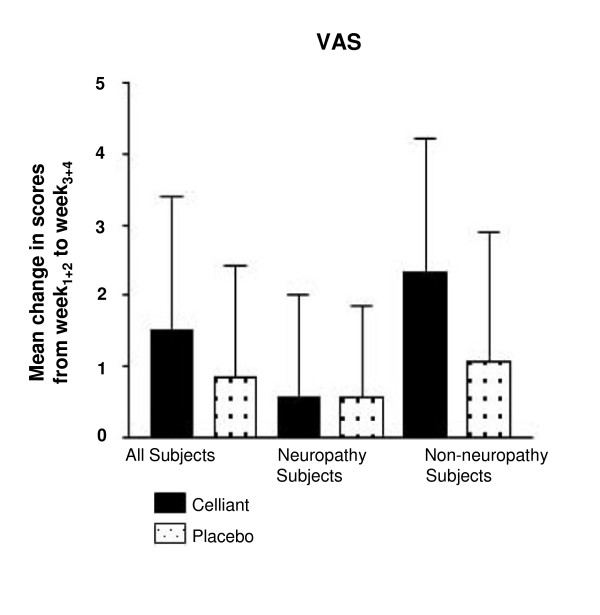
Results of the VAS. The difference between mean W1+2 and mean W3+4 scores is depicted. Solid bars report Celliant™ and stipled bars report control subjects.